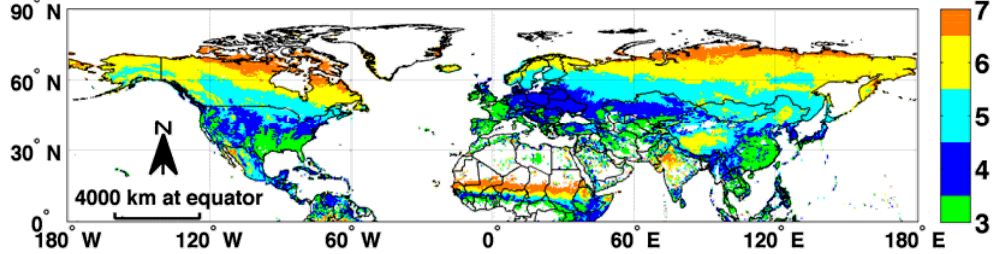
Figure 8. Start of growing season for cycle 1 in the Northern Hemisphere. Vegetation phenology data are the V4 MODIS Land Cover Dynamics (MOD12Q2, [65,66]) product from http://duckwater.bu.edu/lc/datasets.html. Unit: month in the year (Spatial resolution: